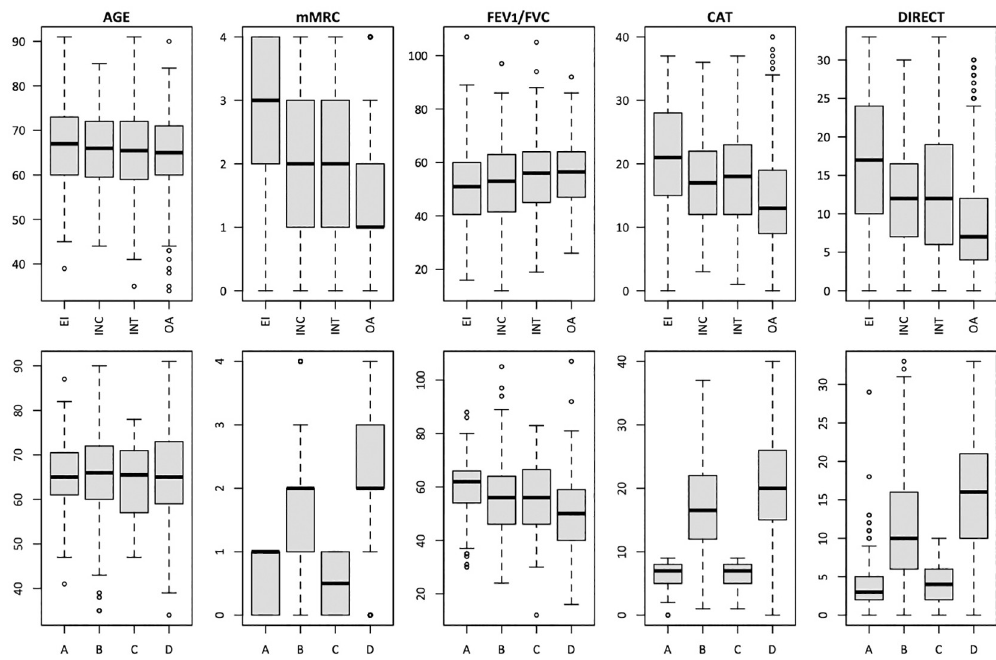
Fig 2. Univariate boxplots comparing the distribution of selected continuous variables according to the physical activity category described here (top row) and GOLD 2017 category (bottom row). Plots show the median, minimum, maximum, and interquartile values. See Table 1 for definitions of activity